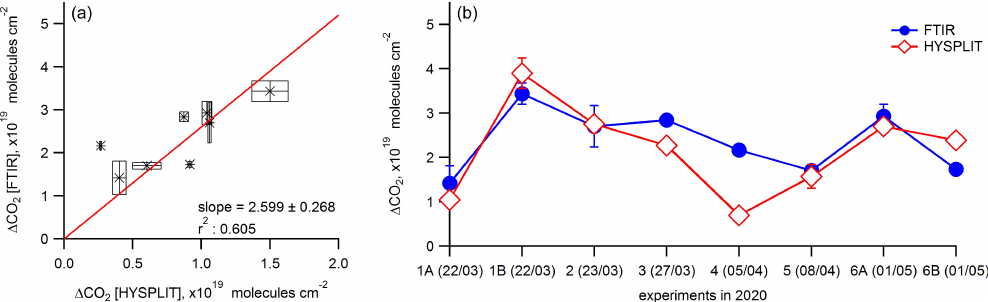
Figure 10. (a) The values of (cid:49) CO 2 (see text) acquired during the field FTIR observations in 2020 compared with the results of HYSPLIT simulations before the process of scaling of the ODIAC data. Measurement and simulation data are averaged over time intervals of FTIR measurements. (b) HYSPLIT data obtained using scaled ODIAC CO 2 emissions are compared with observed (cid:49) CO 2 . Dots are connected by lines for illustrative purposes